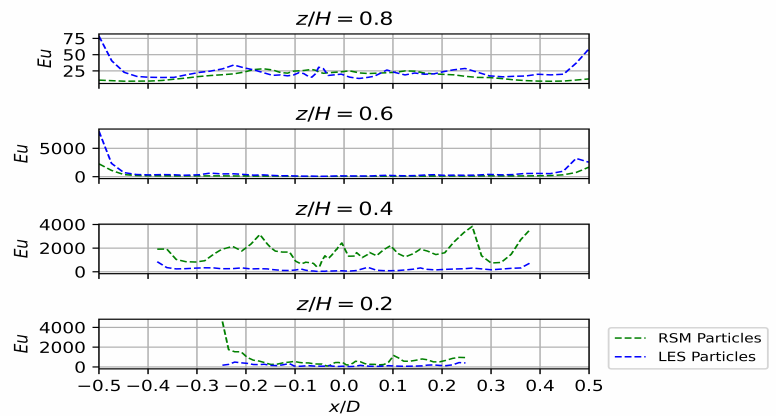
Figure 23. Euler Number for the particle models as a function of the normalised x co-ordinate at various heights at flow-time 4